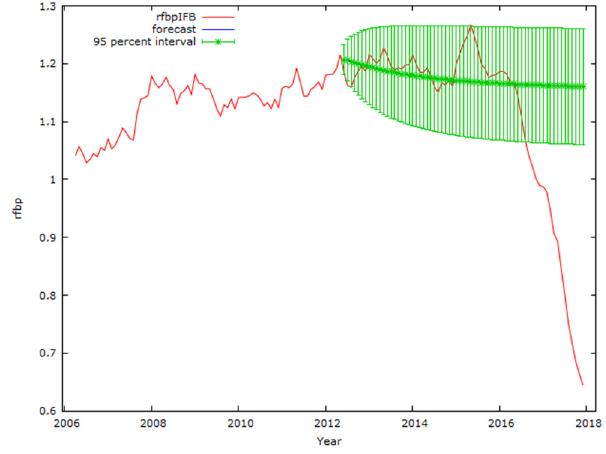
Figure A9. Time series forecasting in VAR model for IFB, the in-sample January 2000–May 2012,